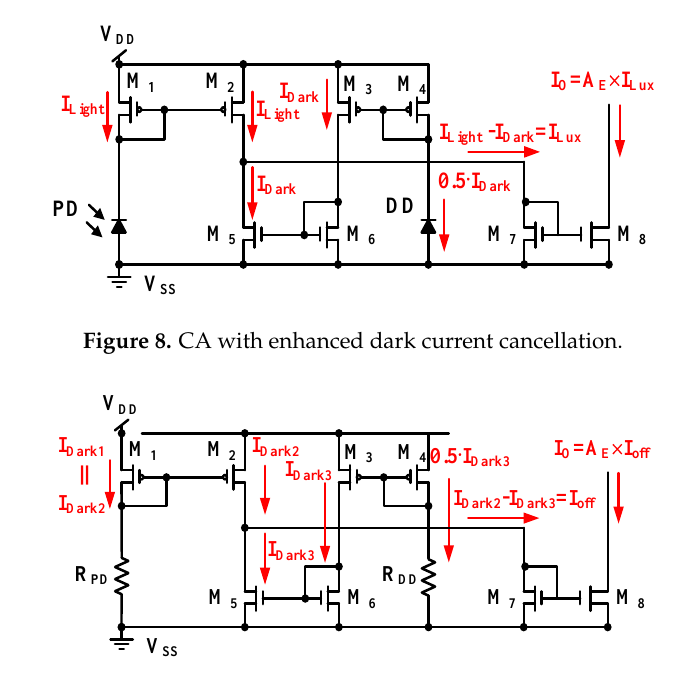
Figure 9. Dark currents of all MOSFETs in the proposed CA with enhanced dark current cancellation.